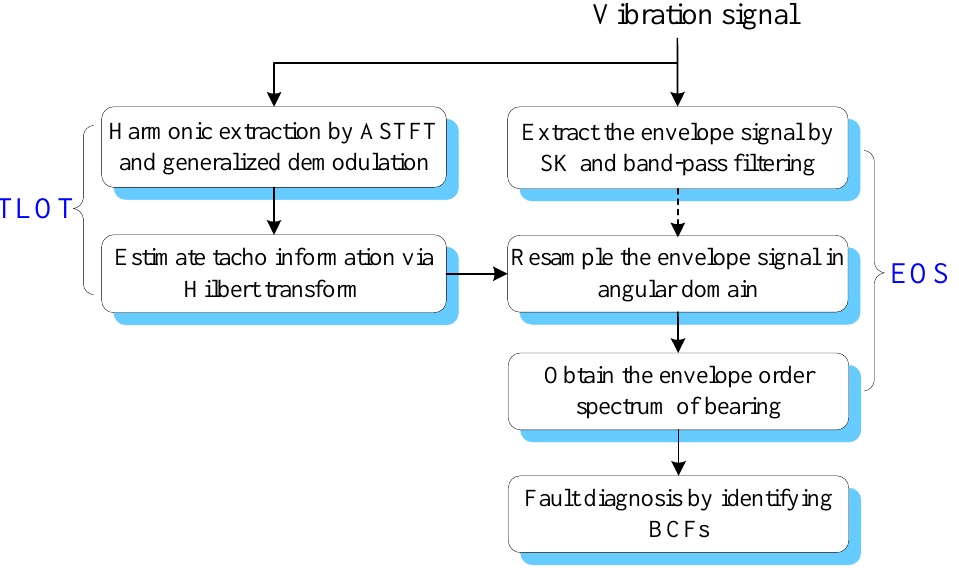
Figure 2. Flow chart of the proposed tacholess envelope order analysis